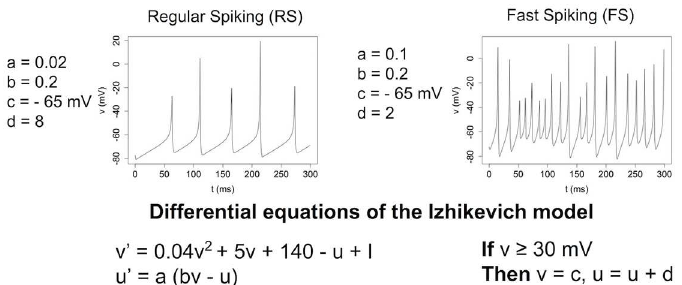
Fig 1. Equations and dynamics of regular spiking and fast spiking neurons simulated with the Izhikevich model. Equationsand dynamics of regularspiking and fast spikingneuronssimulatedwith the Izhikevich